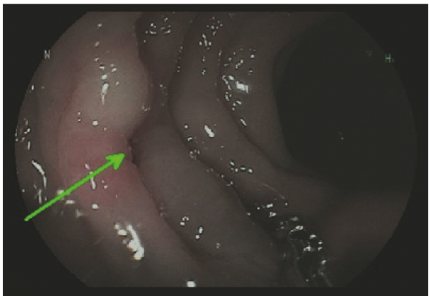
Figure 3: Colonoscopy showing the localized edematous area with bluish discoloration 45cm from the anus that correlated with the area revealed in the CT scan. Green arrow denotes the edematous area on colonoscopy about 45 cm from anus which likely represents fistula’s